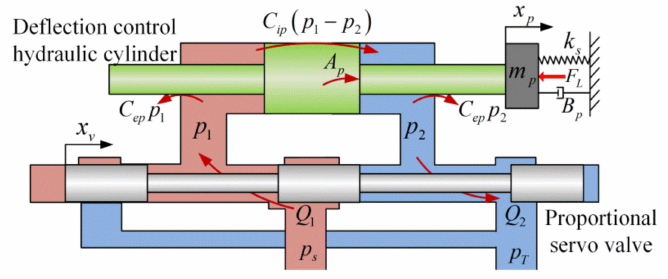
Figure 3. Dynamic model of the deviation control